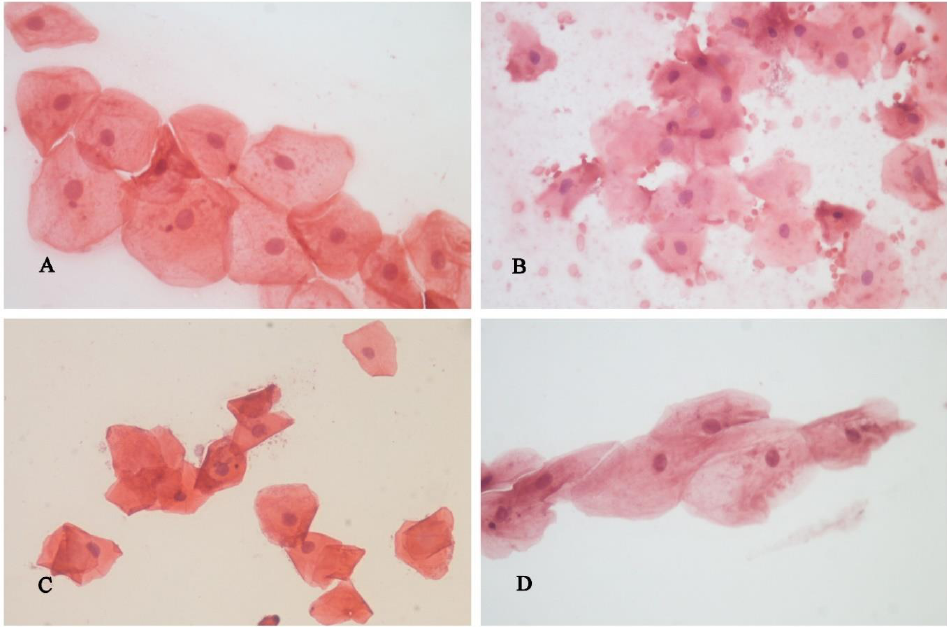
Figure 2. Superficial cells of the squamous gingival epithelium, cytological smear, H&E: ( A ) — before tooth preparation; ( B ) — 15 min after tooth preparation, ( C ) — 24 h after tooth preparation, ( D ) — 72 h tooth preparation; ( B )—15 min after tooth preparation, ( C )—24 h after tooth preparation, ( D )—72 h after tooth preparation. after tooth